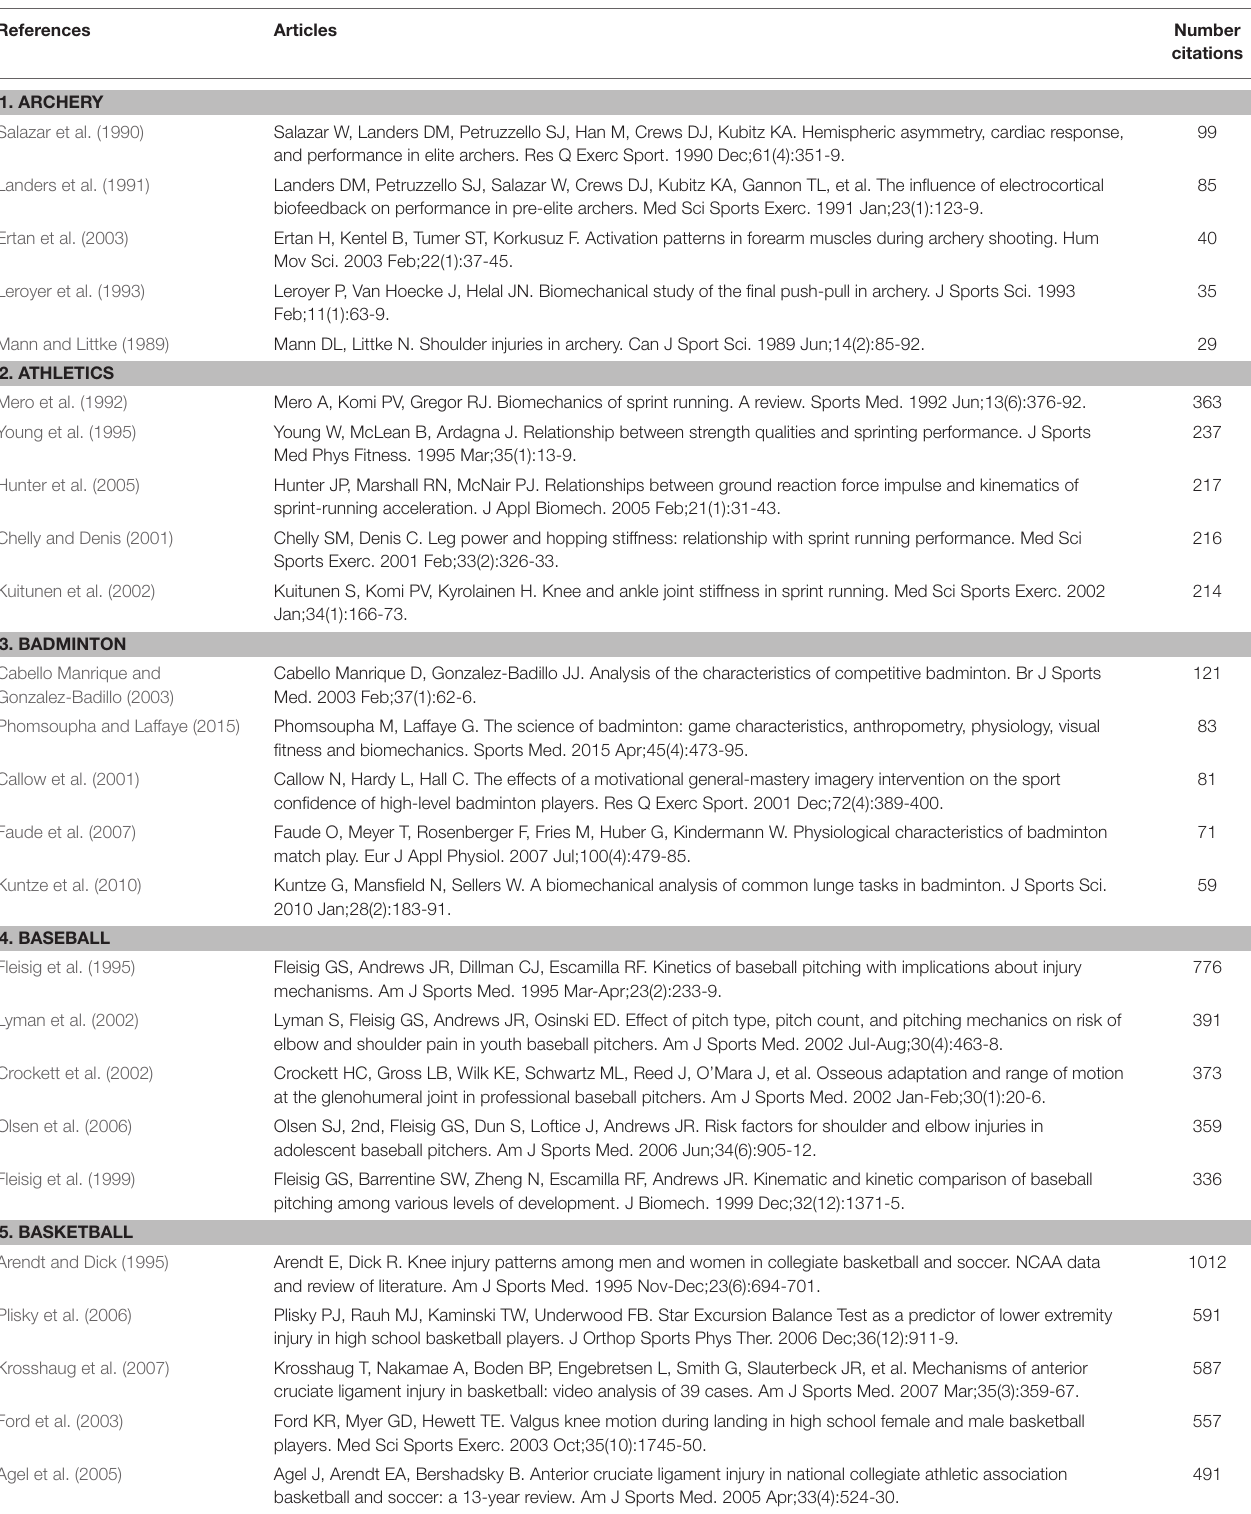
TABLE 4 | Top-5 articles on summer